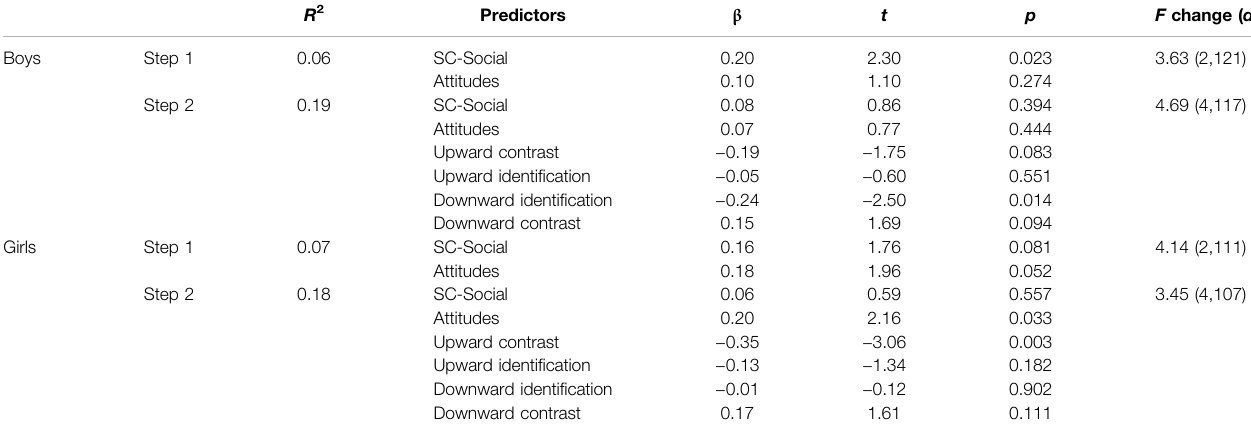
TABLE 3 | Hierarchical multiple linear regression analyses predicting self-concept in language learning (SC-L) across